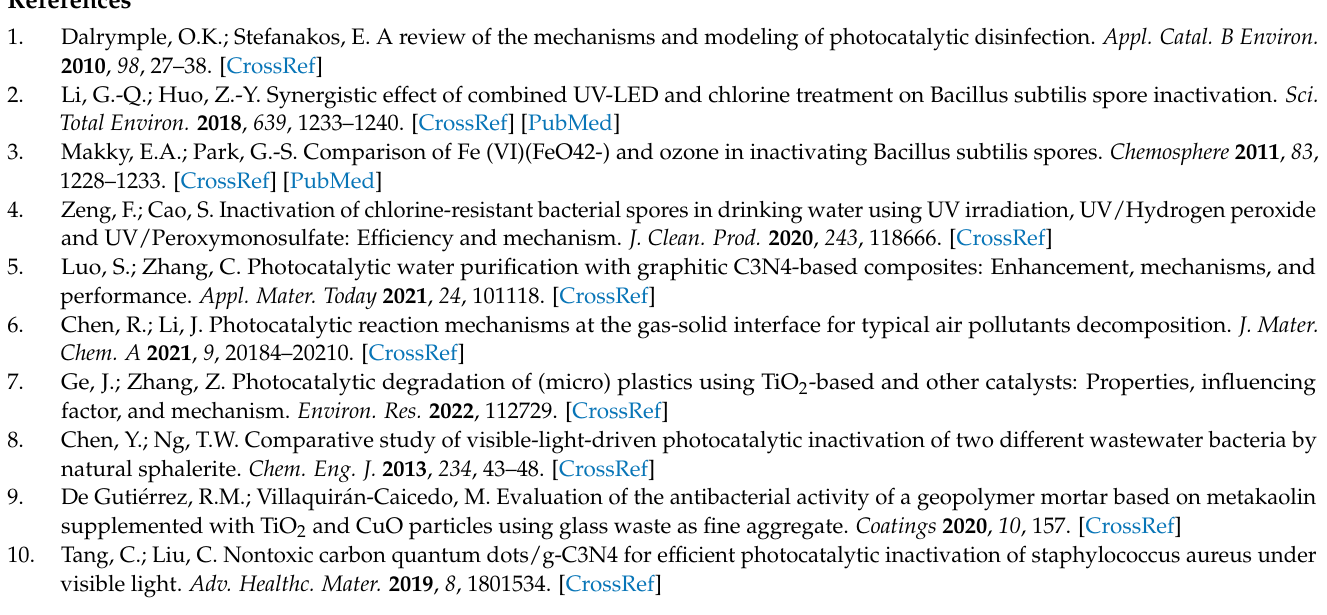
Figure S3: (a–d) SEM images of B. subtilis cultured in NB medium supplemented with different con- centrations of Ca 2+ for 8 days; (e–h) SEM images of B. subtilis cultured in NB medium supplemented with different concentrations of Mn 2+ for 8 days. In both cases, the cell density of produced spores was increased with the increase of metal ions (Magnification: 5000 × ); Table S1: Weight ratio of main metal component in